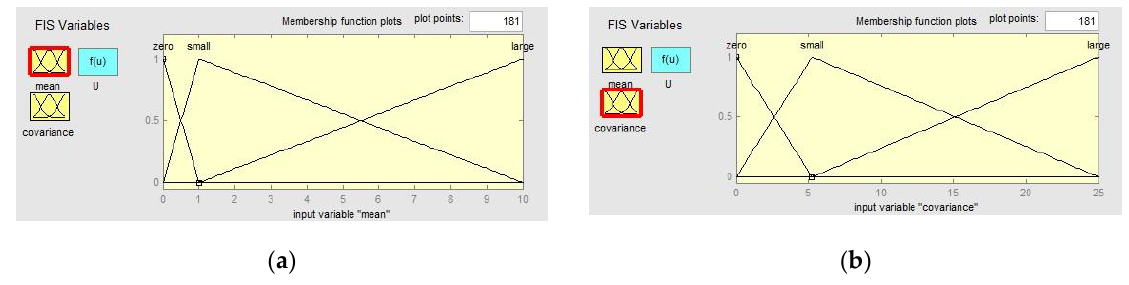
Figure 2. Membership function: ( a ) membership function of input variable “mean”; ( b ) membership function of input variable “covariance”.